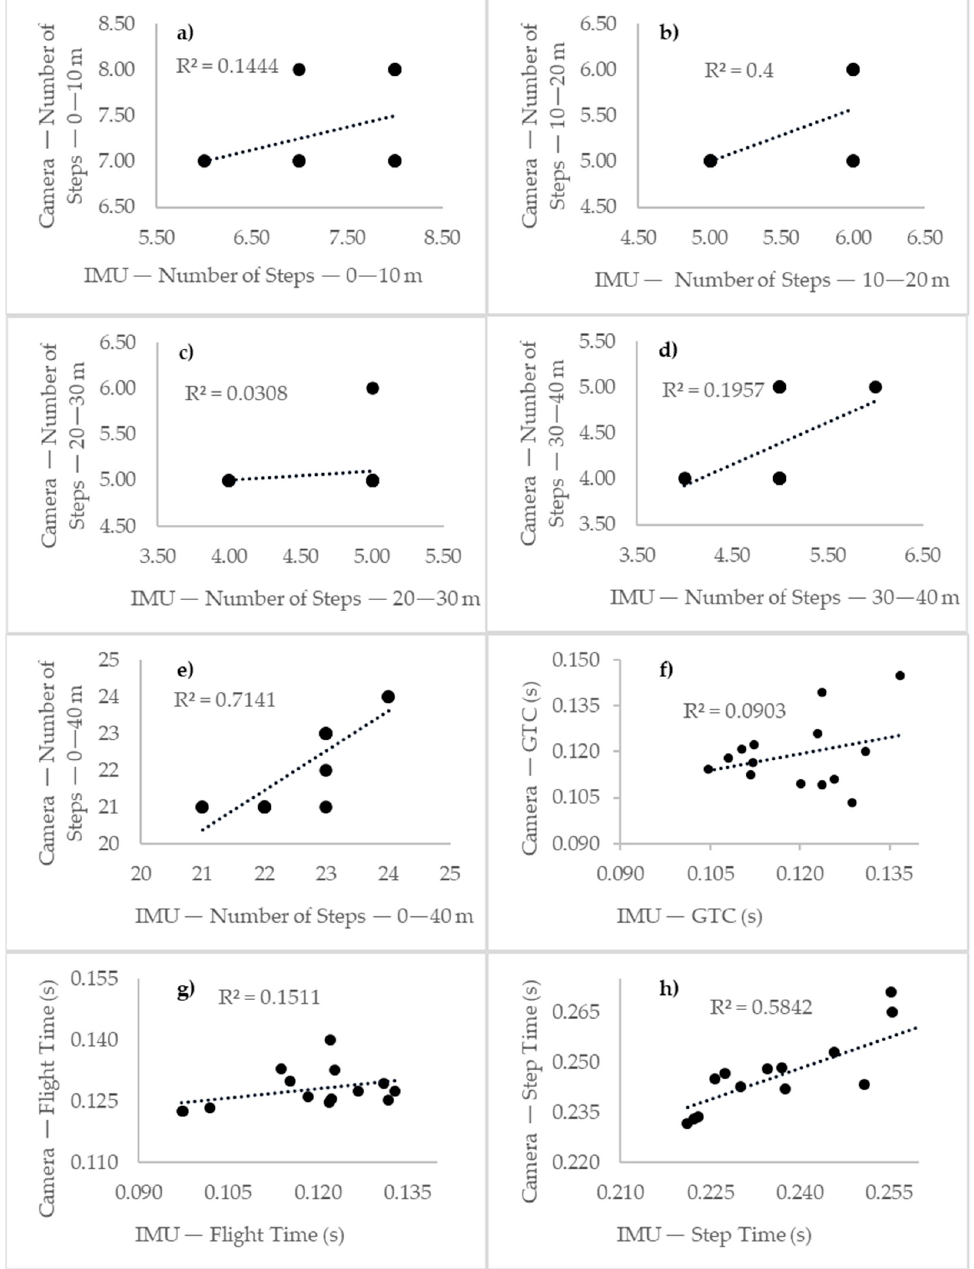
Figure 4. The IMU vs. high-speed camera correlation comparison: ( a ) number of steps—0–10 m; ( b ) number of steps—10–20 m; ( c ) number of steps—20–30 m; ( d ) number of steps—30–40 m; ( e ) num- ber of steps—0–40 m; ( f ) ground contact time (s); ( g ) flight time (s); ( h ) step time (s).